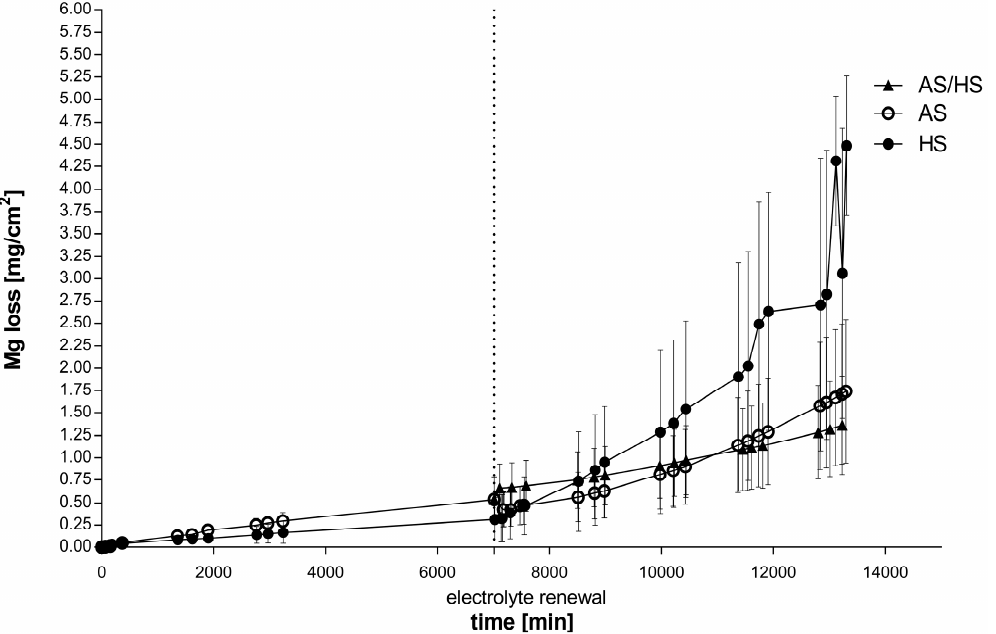
Figure 1. 10-day-corrosion curves of Mg-0.6Ca-0.8Zn wt.% in Hank’s balanced solution, artificial saliva as well as AS/HS (5 days artificial saliva, 5 days Hank’s balanced solution) Electrolyte contents of the control groups were renewed after 5 days. Each experiment was repeated at least 3 times. Values are shown as means.